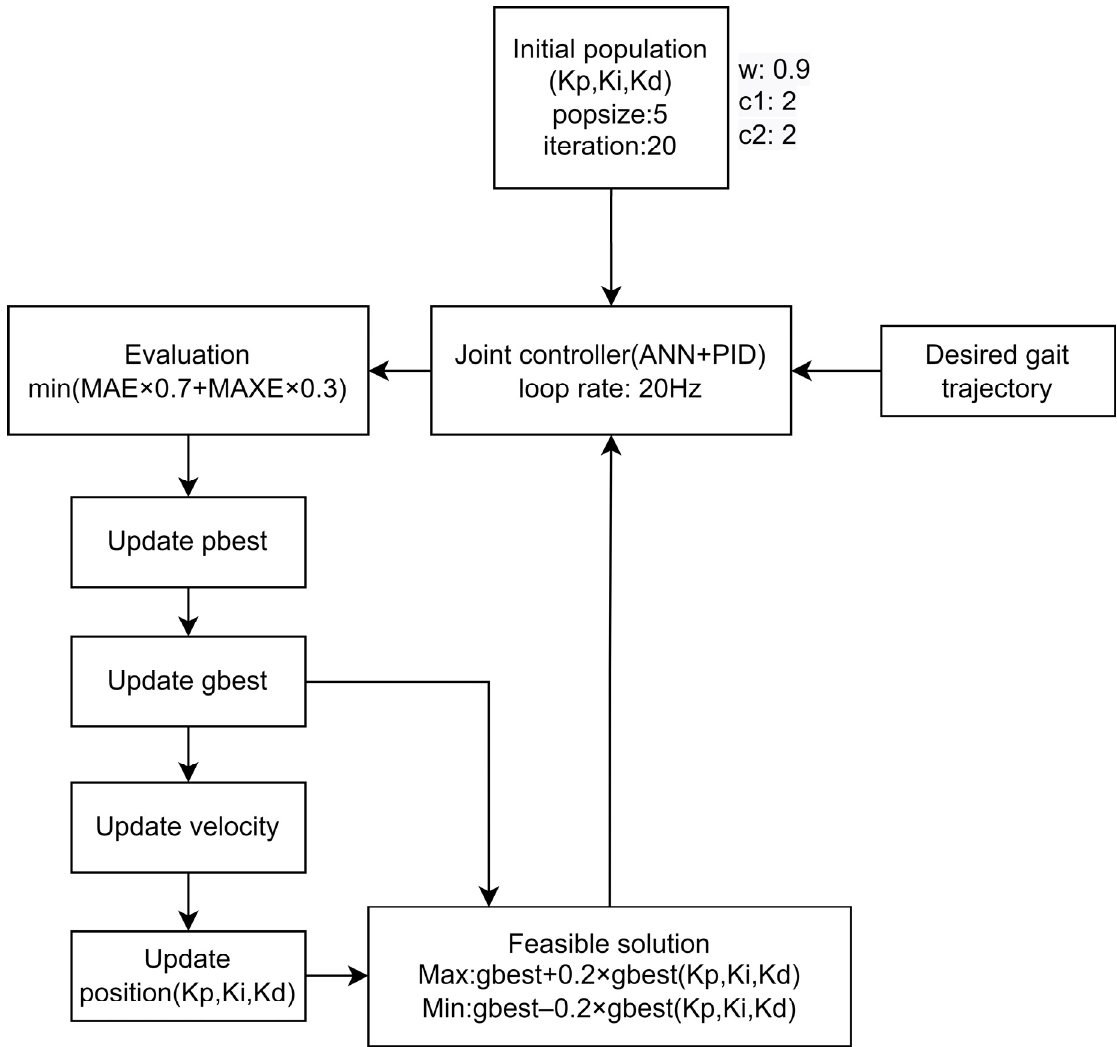
Figure 18. PSO tuned PID with ANN flow chart. When the PSO controller iterates for 20 times, the optimal objective function changes as shown in Figure 20. Figure 21 shows the response with the PID optimization adjustment, after the PSO optimization is performed. With the comparison to Figure 17 (at 1 s), the controller after the PSO adjustment has a better performance than the original in Section 4.1. After the PSO adjustment of the parameters, the MAXE has changed from 4.4 to 3.9 with some overshoot at 3.7 s. Figure 22a shows the difference of the time response for the controllers of PID, ANN + PID, and ANN + PID (PSO adjustment). After adjusting PID parameters, the tracking error is better than the original and the overall MAE decreases as shown in Figure 22b, especially around 1 s. The control signal given by the ANN compensation with the PID can reduce the error very